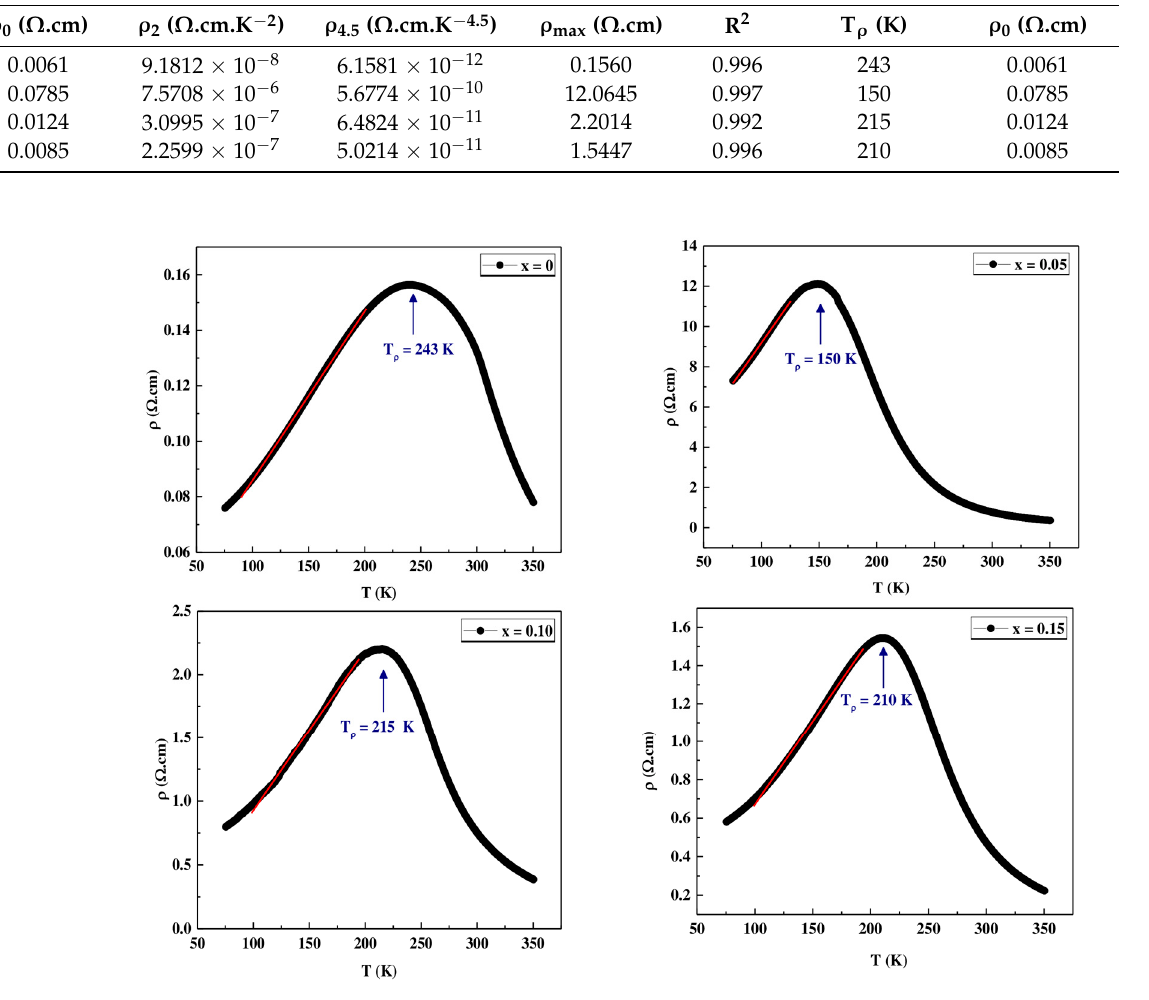
Figure 13. Plots of the electrical resistivity ρ (T) vs. T, for Pr 0.7 Sr 0.3 Mn ( 1 − x ) Co x O 3 (x = 0, 0.05, 0.10 and 0.15). The red line corresponds to fit by with Equation (9). Table 8. Fit parameters to Equation (9) obtained for the metallic behavior (below T 𝜌 ) for Pr (cid:2868).(cid:2875) Sr (cid:2868).(cid:2871) Mn ((cid:2869)(cid:2879)(cid:2934)) Co (cid:2934) O (cid:2871) samples (0 ≤ x ≤ 0.15) and Metal-semiconductor transition temperature T 𝜌 .